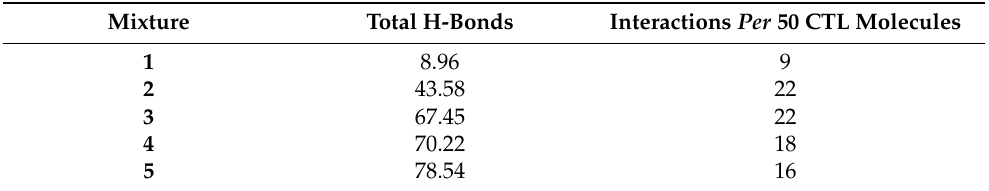
Table 3. Total average number of hydrogen bonds at different pre-polymerization compositions and their corresponding interactions as a function of CTL